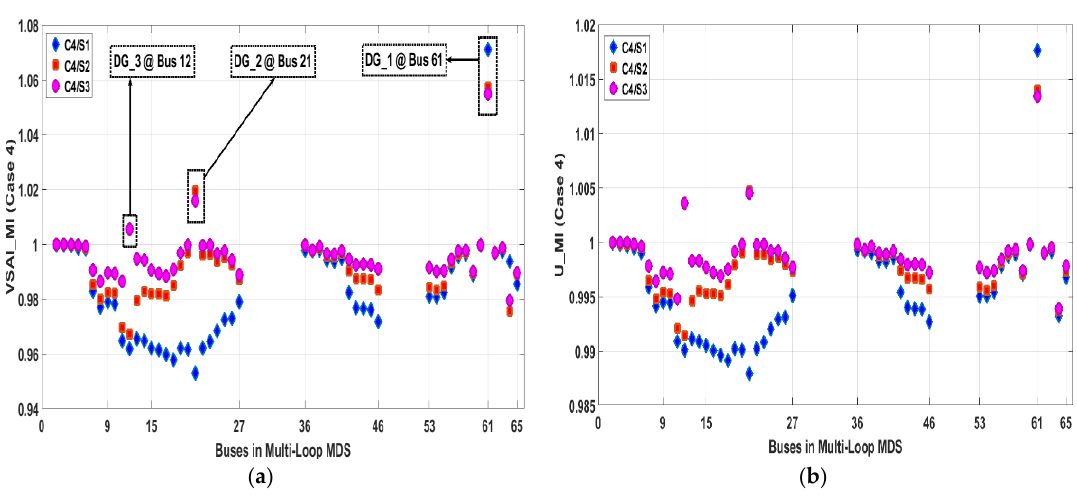
( b ) Figure 18. Case 4 for 69-bus MDS L_Min ( a ) VSAI trend (based on ideal MDS) for VSAI_MA-LMC; and ( b ) U-profile trend for VSAI_MA- LMC, based planning approach (DG @ pf = 0.82 ± 2.5%). Evaluation of results pertaining to C4 with all associated scenarios is presented in Table 6. The comparative analysis of C4 with all relevant scenarios from the viewpoint of PEIs are illustrated in Figure 19a,b. It is also interesting to know that increase in reactive power support from DG have result in almost the same U_profile trend as achieved in C3. It is observed in Table 6 that a significant PLM and QLM by percentage have been achieved with improved optimal PDG , in comparison with C3. From a comparison perspective of C1 – C2 (33-Bus TDS), less PDG has observed in C3 – C4 (69-Bus TDS). It is interesting to observe that 33-Bus TDS is a heavy loaded system as compare to 69-Bus-TDS on load distribution level. Similarly, Table 6 shows that a substantial decrease is observed in-terms of PLC and improved PLS margin. The ACI trend in C4 has surpassed C3 across all scenarios. Although ACI is high, however, it can be justified with improved PEI results and cost to benefit analysis across load growth. Since load growth across planning horizon is out of the scope of this paper. In future, a multi-objective based trade-off solution across a load growth will be addressed in our future publications.